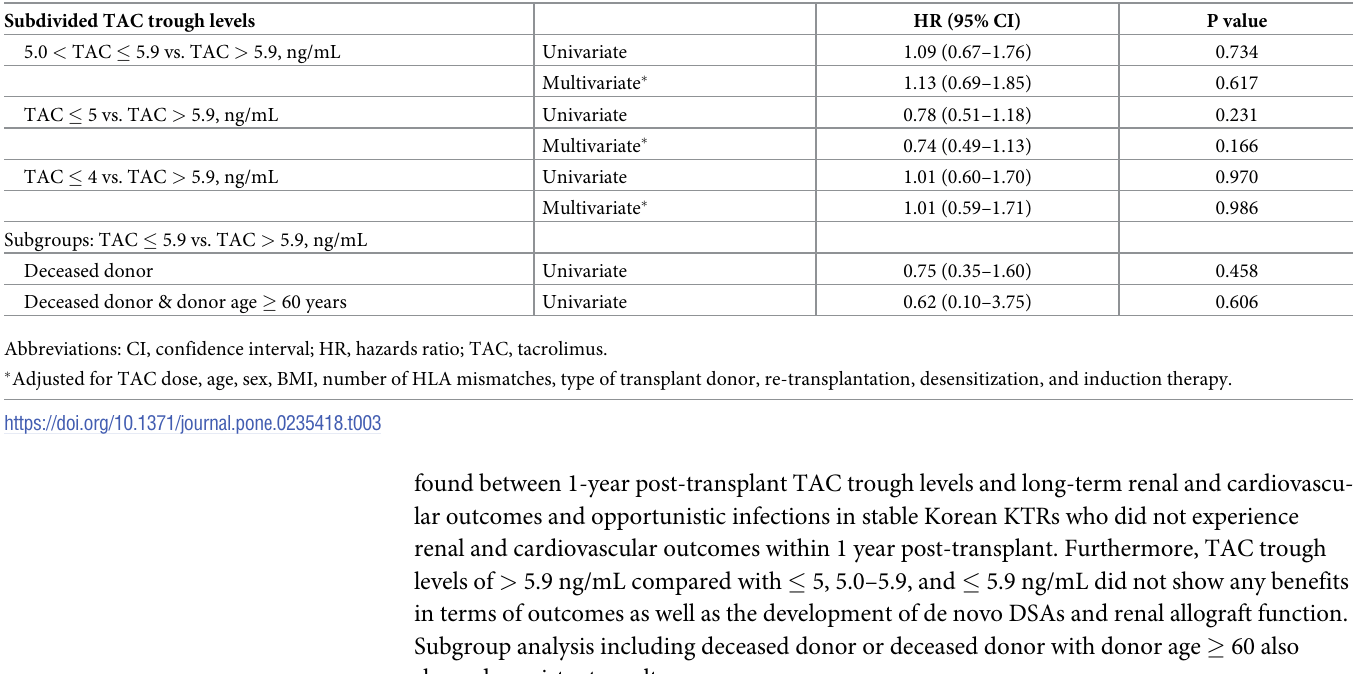
Table 3. Univariate and multivariate Cox regression analysis for renal composite endpoints in subgroups. Subdivided TAC trough levels